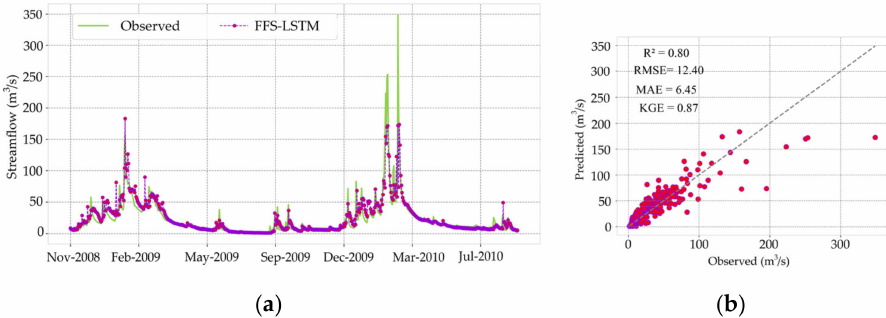
Figure 11. The hydrograph of observed and predicted daily streamflow of FFS-LSTM scenario during the testing ( a ) using approach 3 (CV = 5) at TS = 10 with the corresponding scatter plot ( b